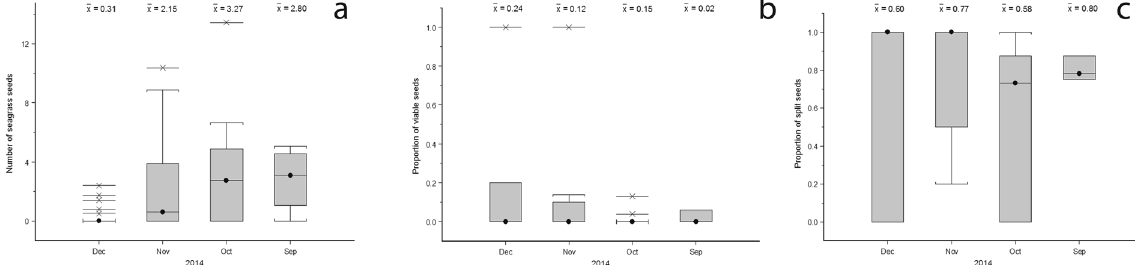
Figure 2. Mean monthly ( a ) number of seagrass seeds ( Zostera muelleri , Halodule uninervis , Halophila ovalis , and Halophila spp .) per g DW mega-herbivore faecal matter; ( b ) proportion of seeds with a split seed coat per g DW faecal matter; ( c ) proportion of viable seagrass seeds found per g DW faecal matter collected across all sampling sites between September and December 2014. Crosses indicate data outliers for the sampled months and the box plots indicating the median, quartiles and 95 percentiles.